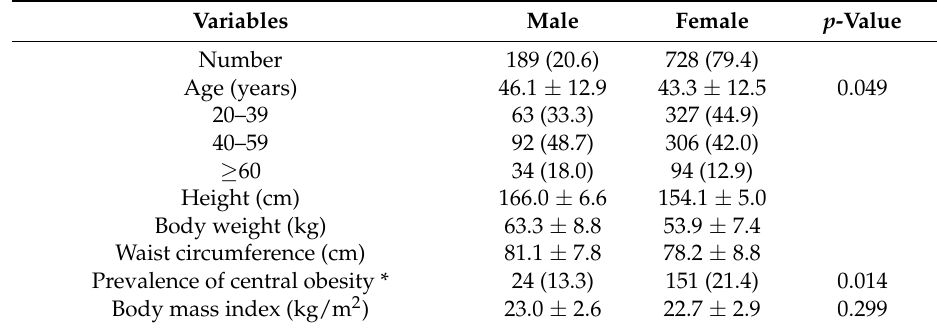
Table 1. General characteristics of North Korean refugees